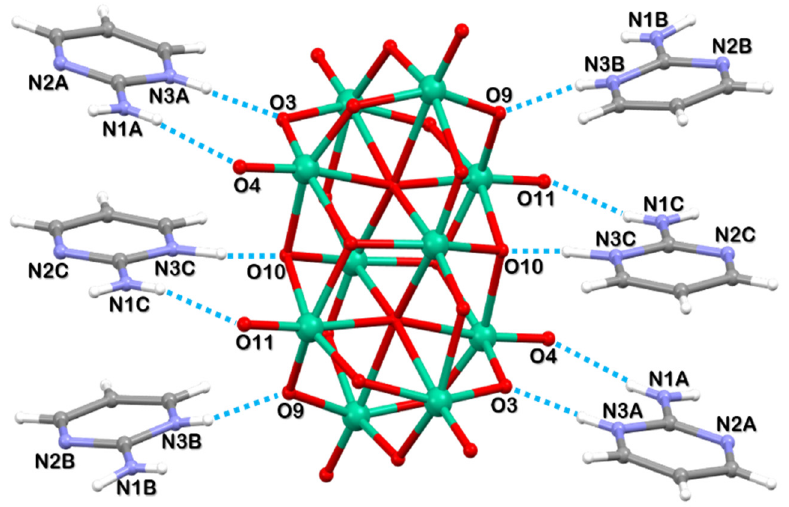
Figure 1. Structure of [2-ampymH] 6 [V 10 O 28 ] · 5H 2 O ( 1 ). The hydrogen bonds among [2-ampymH] + cations and decavanadate anion are shown (blue dashed line). Water molecules have been omitted for clarity. Vanadium atoms are represented in green.